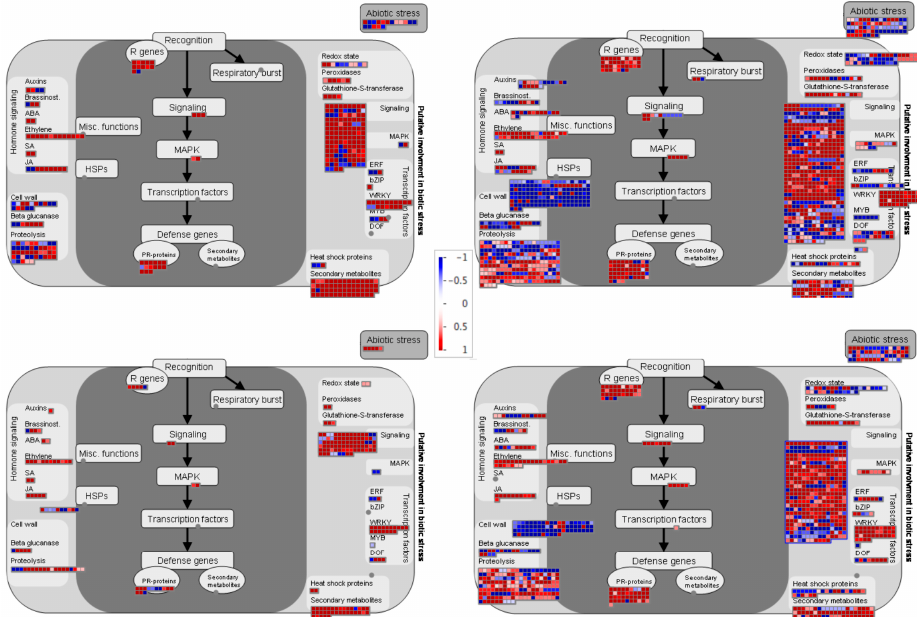
Figure 6. MapMan overview of the biotic stress pathway of DEGs in BAT93 inoculated plants during compatible and incompatible interactions at 48 hpi and 72 hpi. DEGs are represented by squares colored in red (Up-regulated) or blue (Down-regulated) following the scale bar displaying changes in gene expression values in LogFC (Center).